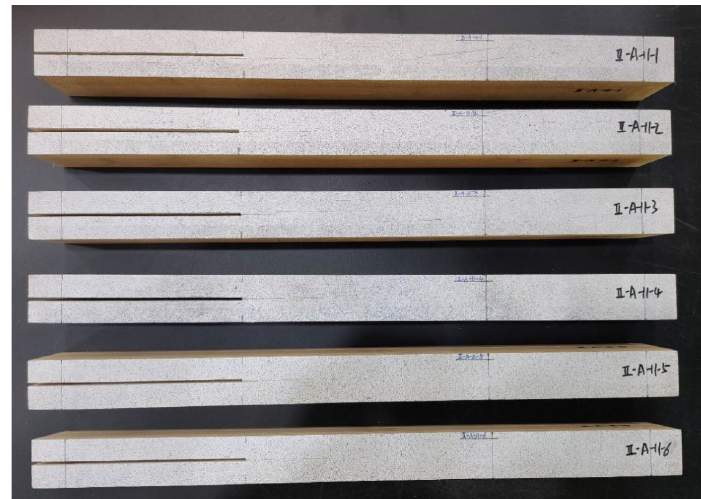
Figure 4. Experimental procedure .